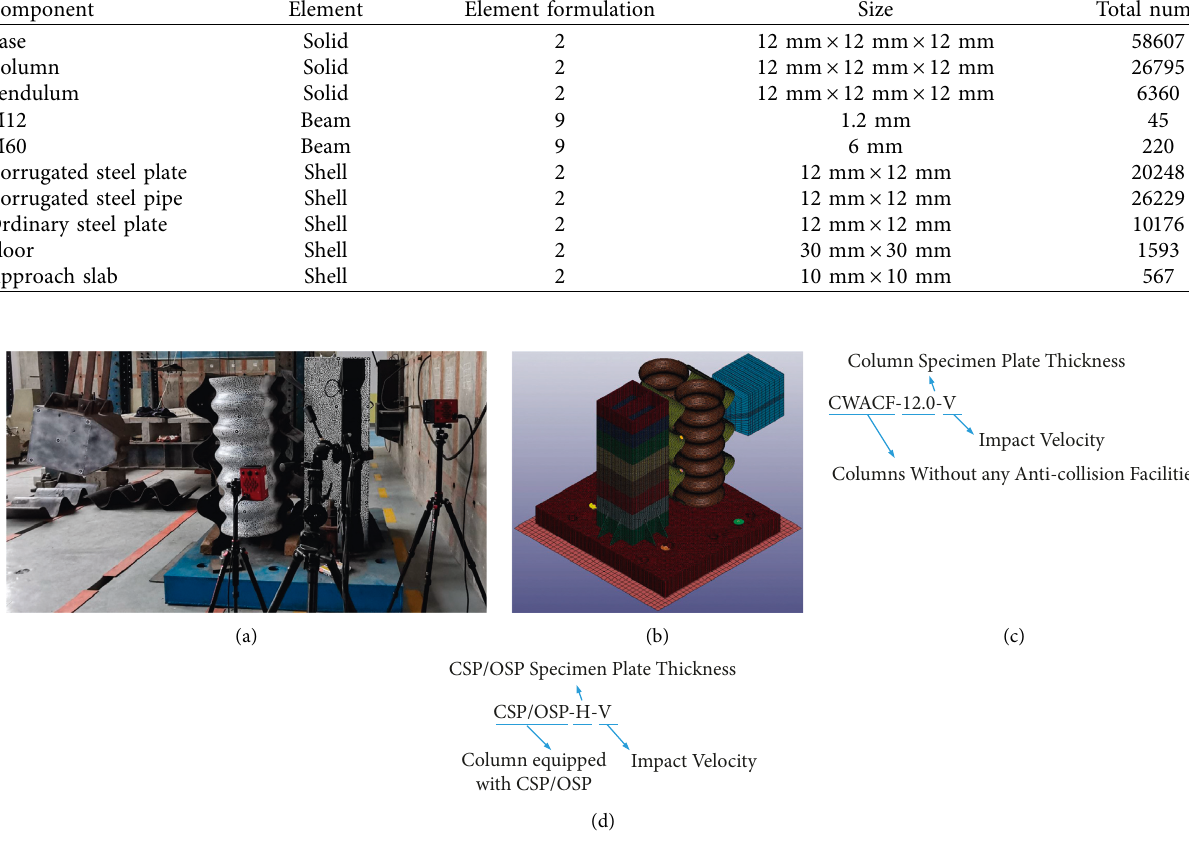
Figure 2: Description of model and case number. (a) Field test model of CSP-2.75-4; (b) finite element model of CSP-2.75-4; (c) description of the case number of the column without anticollision facilities; (d) description of the case number of the column equipped with CSP/OSP.